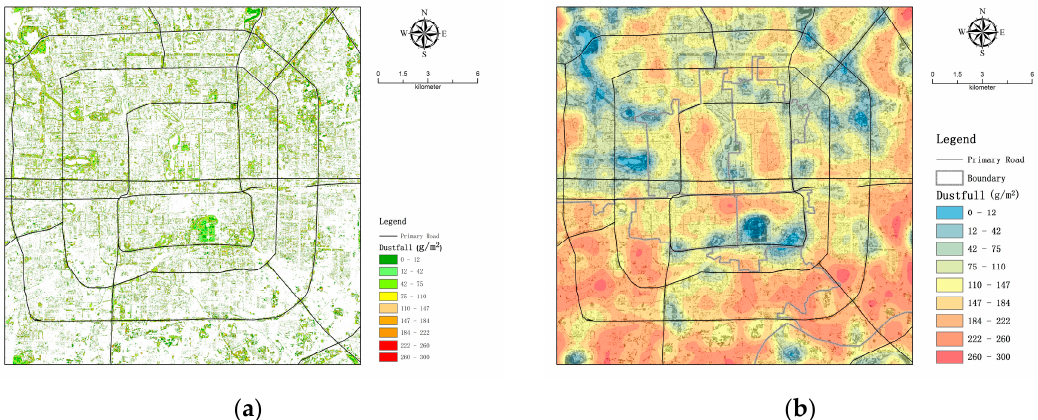
Figure 8. ( a ) Dust retention distribution of vegetation-covered areas in Beijing and ( b ) nuclear density analysis of dust retention distribution.